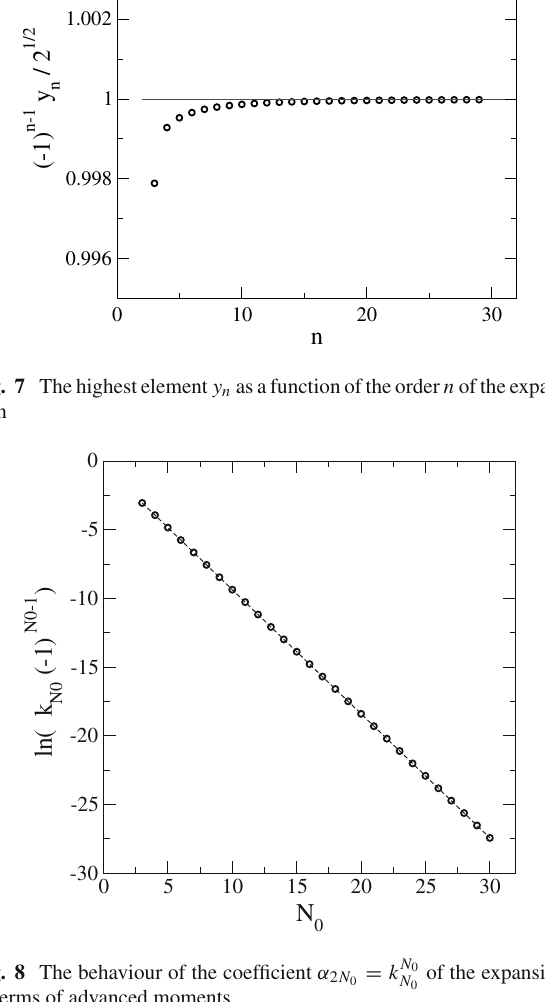
Fig. 8 The behaviour of the coefficient α 2 N in terms of advanced moments